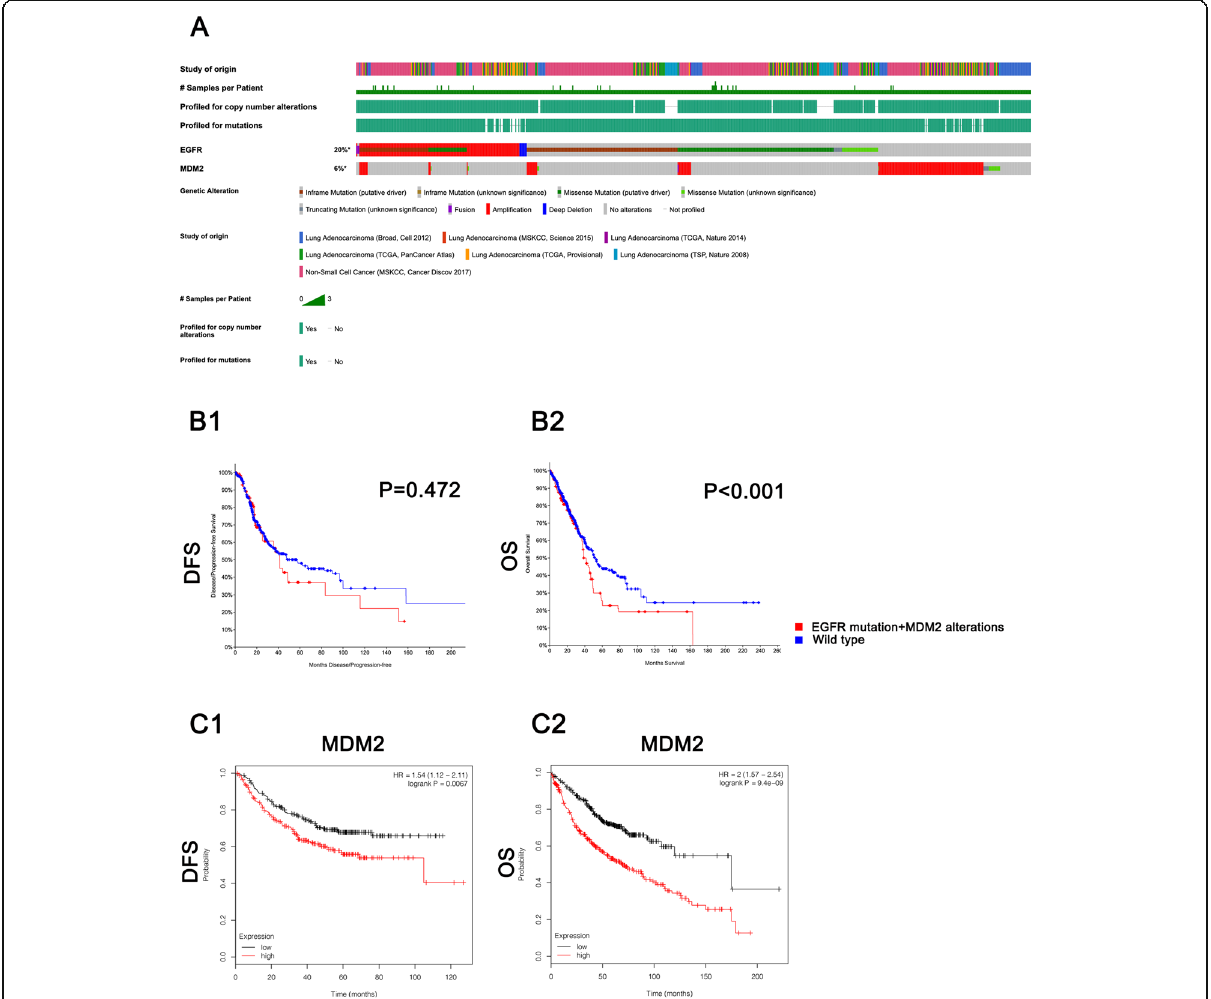
Fig. 3 MDM2 amplification predicts a poor prognosis in NSCLC patients. a The genomic signatures of NSCLC patients derived from cBioportal for Cancer Genomics: 20% NSCLC patients were detected harboring EGFR alterations and 6% of them were detected harboring MDM2 alterations; B1- B2. The survival analyses of NSCLC patients grouped by genomic signatures of EGFR and MDM2 (DFS: disease free survival; OS: overall survival): NSCLC patients harboring the concurrent alterations of EGFR and MDM2 have a poor OS ( P < 0.001); C1-C2. The survival analyses of NSCLC patients grouped by MDM2 expression: NSCLC patients with higher expression of MDM2 demonstrate poor DFS ( P = 0.0067) and OS ( P <